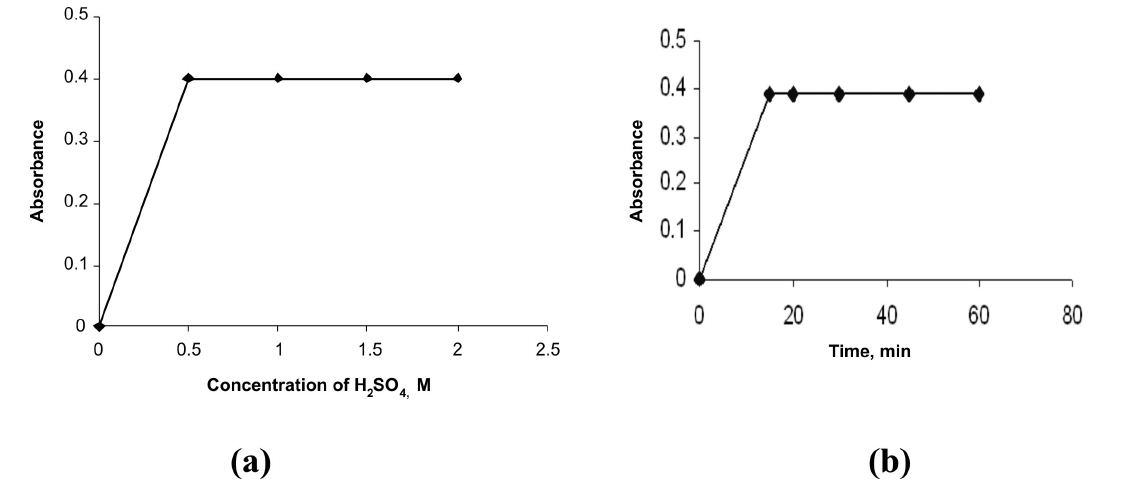
SO concentration and reaction time (method A). (a) . Effect of H 2 4